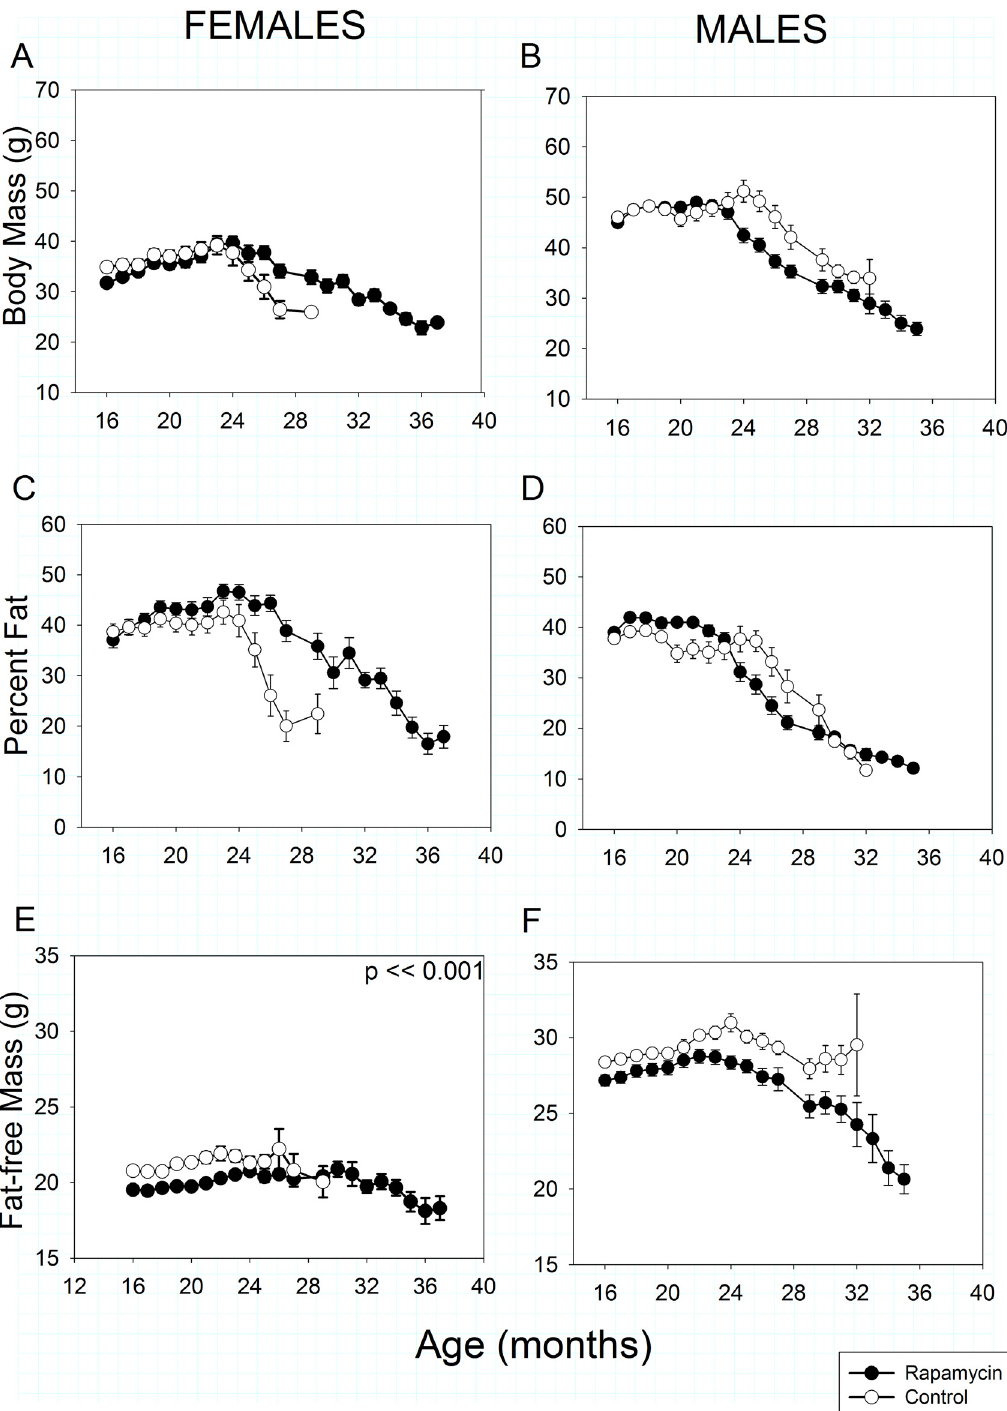
Fig 2. Body mass and composition in rapamycin-fed mice (filled circles) versus controls (hollow circles). P-values shown on individual panels only if there is a significant treatment effect independent of age. Sample sizes varied, depending on age, control females, n = 32 – 2; rapamycin females, n = 30 – 4; control males, n = 33 – 2; rapamycin males, n = 36 – 3. A, B: Total body mass. Highly significant differences (p << 0.001) exist in treatment x age effects in body for both sexes. Although they weighed less than controls by 16 months of age, rapamycin-fed females retained body mass longer, whereas rapamycin- fed males were similar to controls at 16 months but lost body mass earlier and remained lighter as they aged. C, D: Percent body fat. Highly significant differences (p << 0.001) in treatment x age effects exist for both sexes. As in with body mass, aging rapamycin-fed females retained body fat longer and